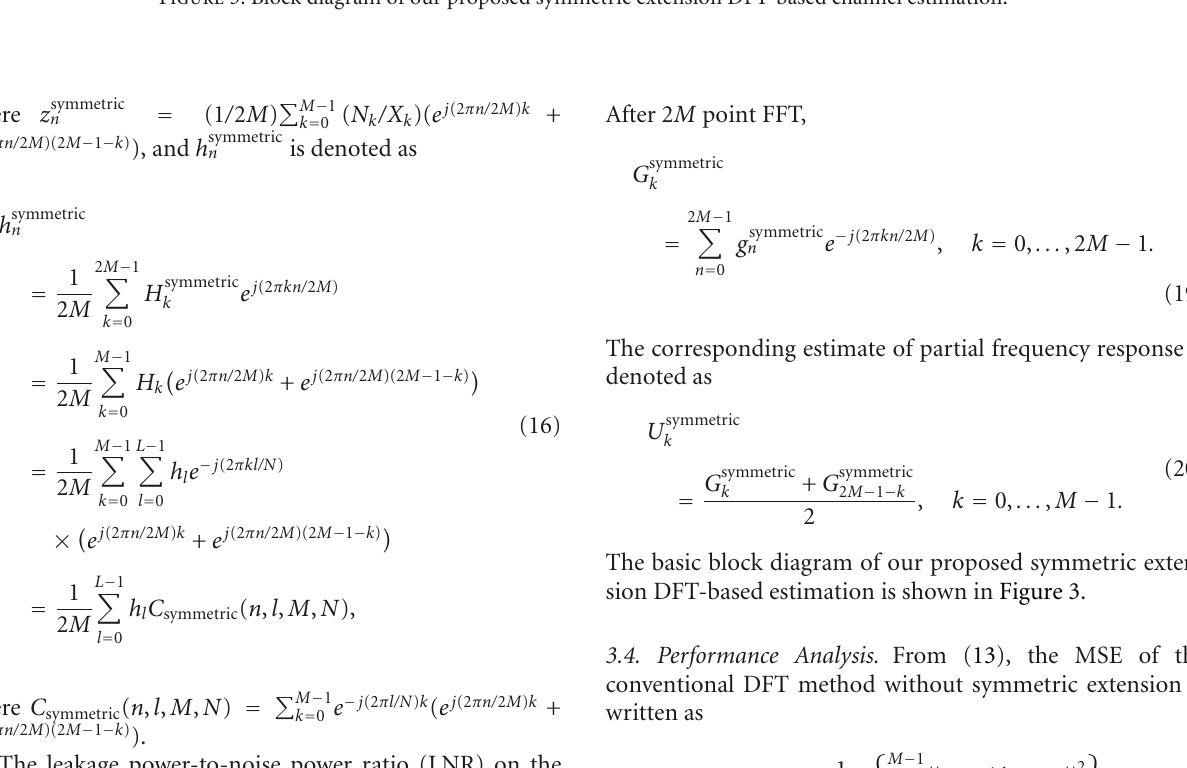
Figure 3: Block diagram of our proposed symmetric extension DFT-based channel